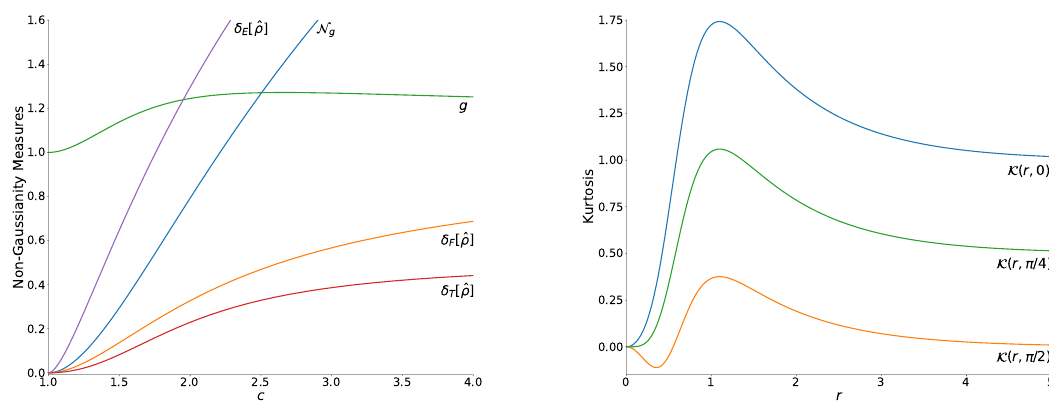
Figure 3. The behavior of the non-Gaussianity measures ( left ) and kurtosis ( right ) as functions of parameters c and r , respectively, for the Even Vacuum Squeezed